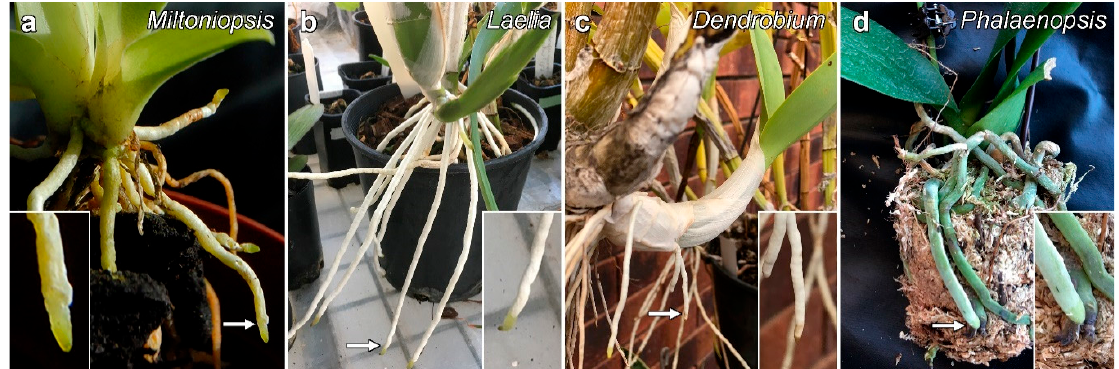
Figure 1. Velamen development in orchid roots. Orchid roots are covered by a thin layer of dead cells called the velamen which appears an off-white colour. Junctions between the newly formed velamen and the growing root are indicated by arrows and are enlarged in the insets. ( a ) Miltoniopsis sp. ( b ) Laelia anceps . ( c ) Dendrobium sp. ( d ) Phalaenopsis sp.